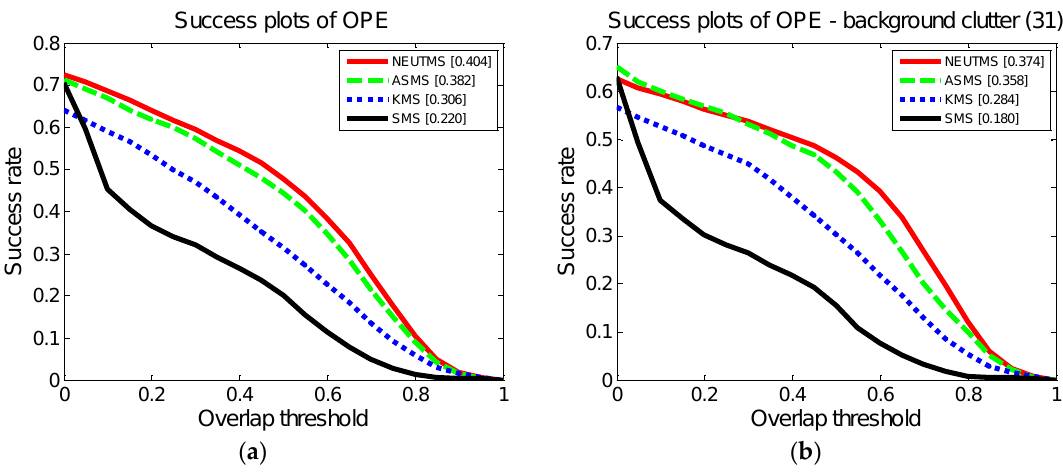
Figure 6. Success plots of one-pass evaluation (OPE): ( a ) Success plots of OPE over all the testing sequences; ( b ) Success plots of OPE over all the 31 testing sequences included the challenge of background clutters (BC). The value shown between the brackets is the area under curve (AUC) value corresponds to the tracker.